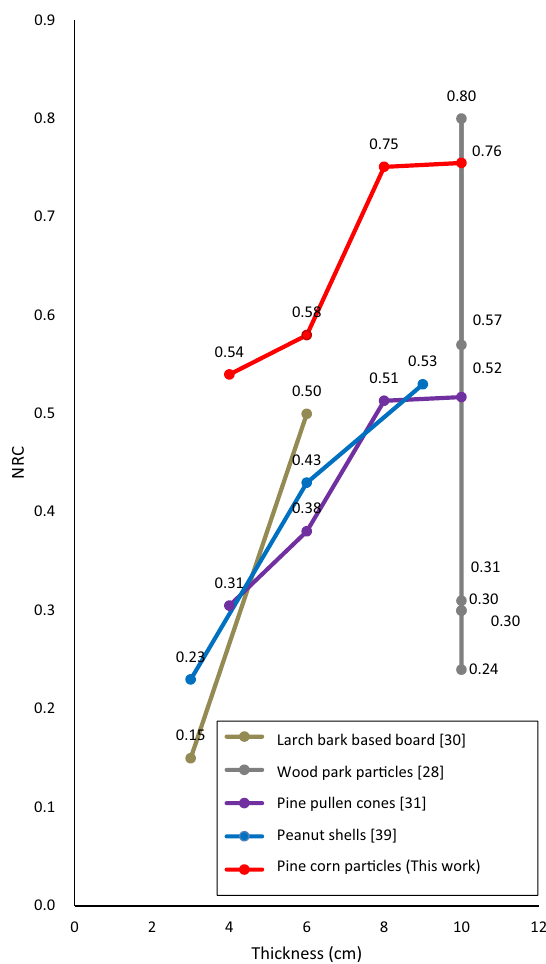
Fig. 5 Comparison of sound‑absorbing capabilities between sound‑absorbing materials manufactured from forest by‑products investigated in previous